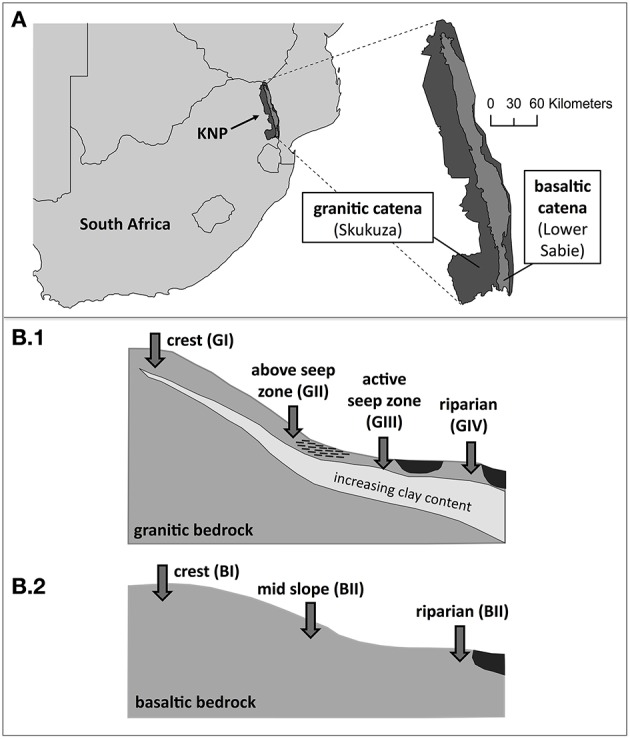
Sampling sites. (A) Schematic map of southern Africa with Kruger National Park (KNP), a simplified overview of the park's geology and locations of both sampled supersites near Skukuza and Lower Sabie, respectively. (B) Schematic overview of the sampling points in 5 cm depths along the two catenas on geologically different bedrock. (B1) Sampling locations at granitic catena: crest (GI), above seep zone (GII), active seep zone (GIII), riparian zone (GIV). (B2) Sampling locations at basaltic catena: crest (BI), mid slope (BII), riparian zone (BIII).